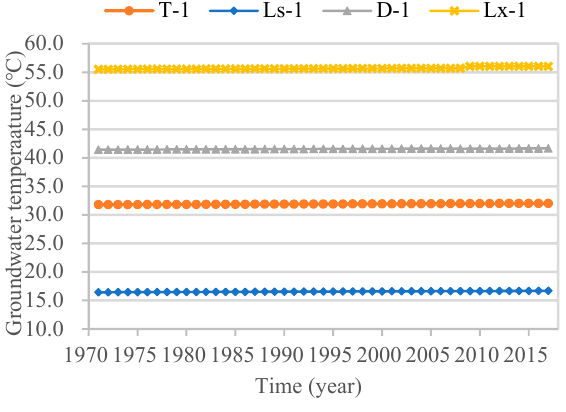
Figure 16. Simulated temperature of different observation points in Layer 1 during the simulated period.